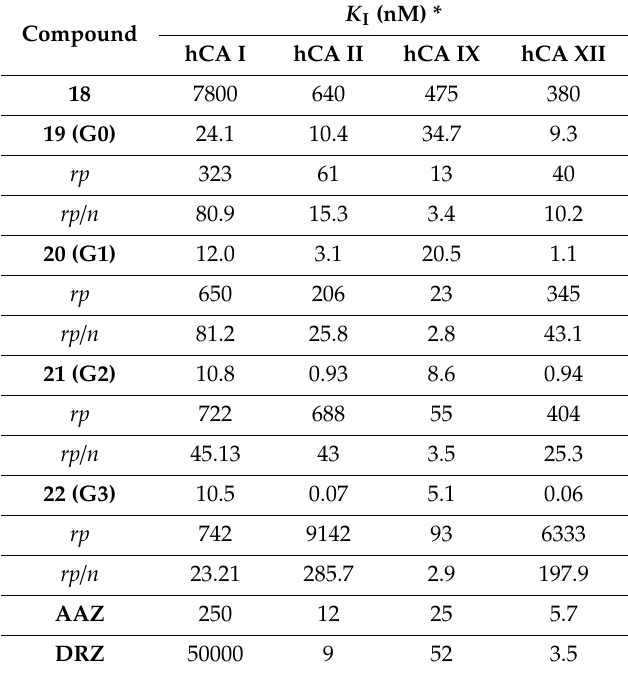
Table 2. CA inhibition data against isoforms hCA I, II, IX, and XII with compounds 19 – 22 and AAZ and DRZ as standards, by a stopped-flow CO 2 hydrase